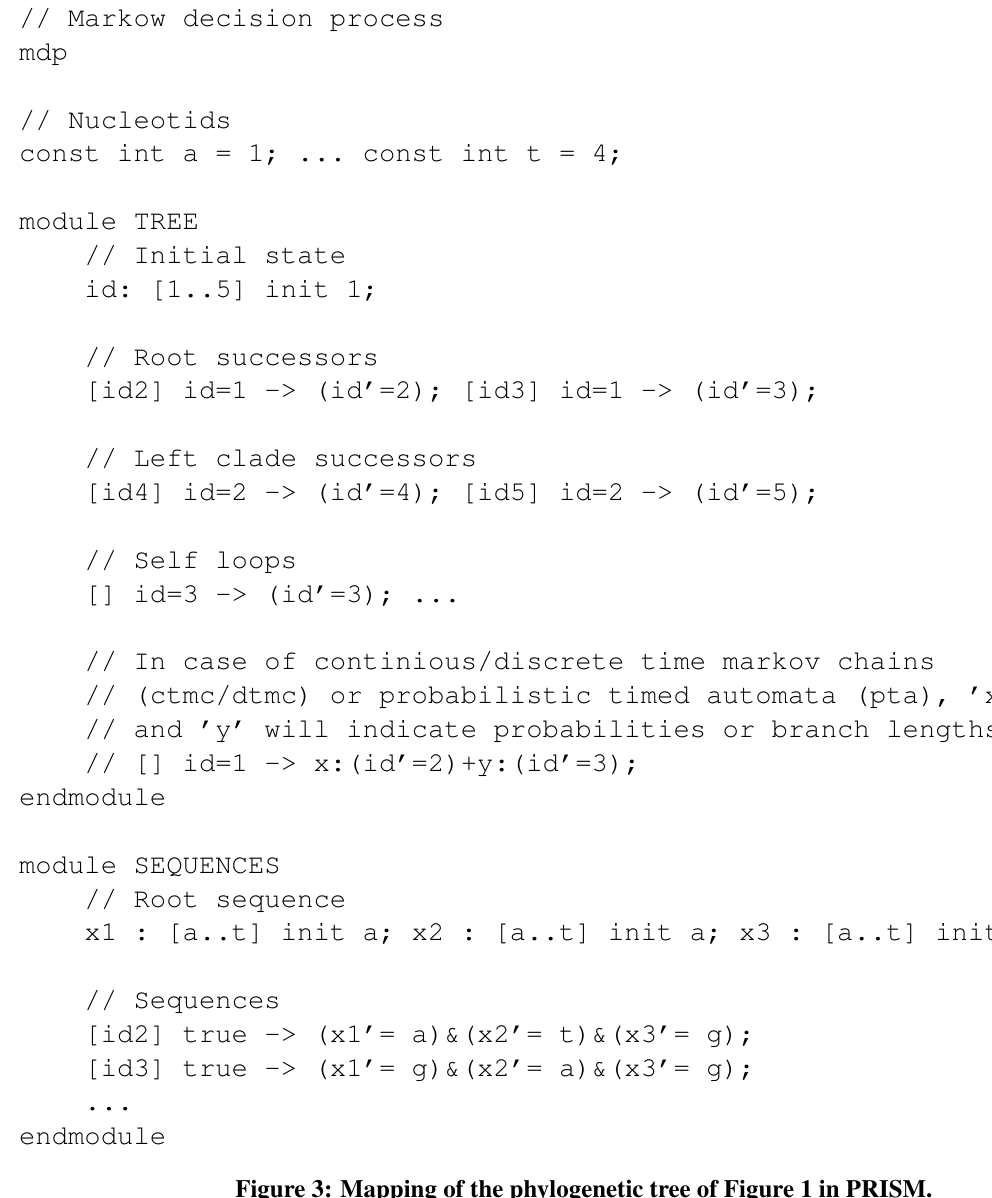
Figure 3: Mapping of the phylogenetic tree of Figure 1 in